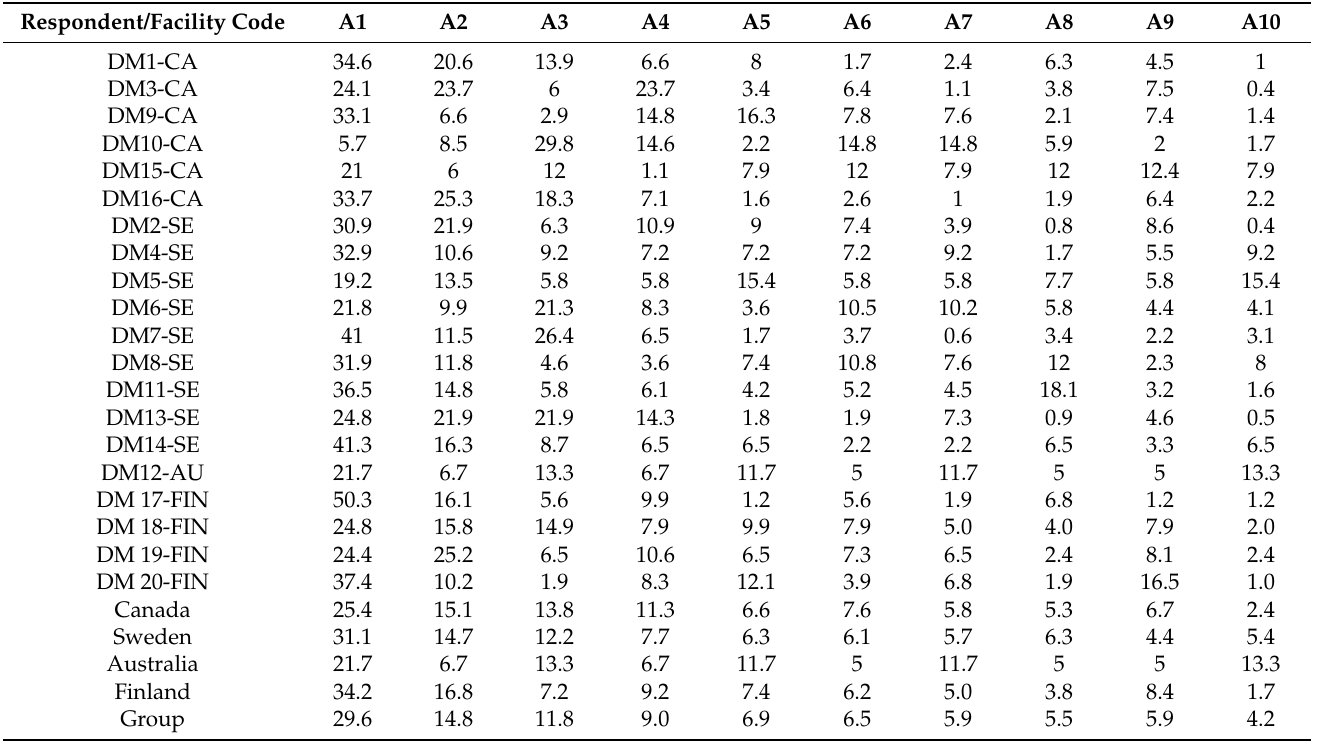
Table A2. Weighting of attributes by respondent, country, and group, presented as a % of all attributes. For definitions of the attributes, see Table